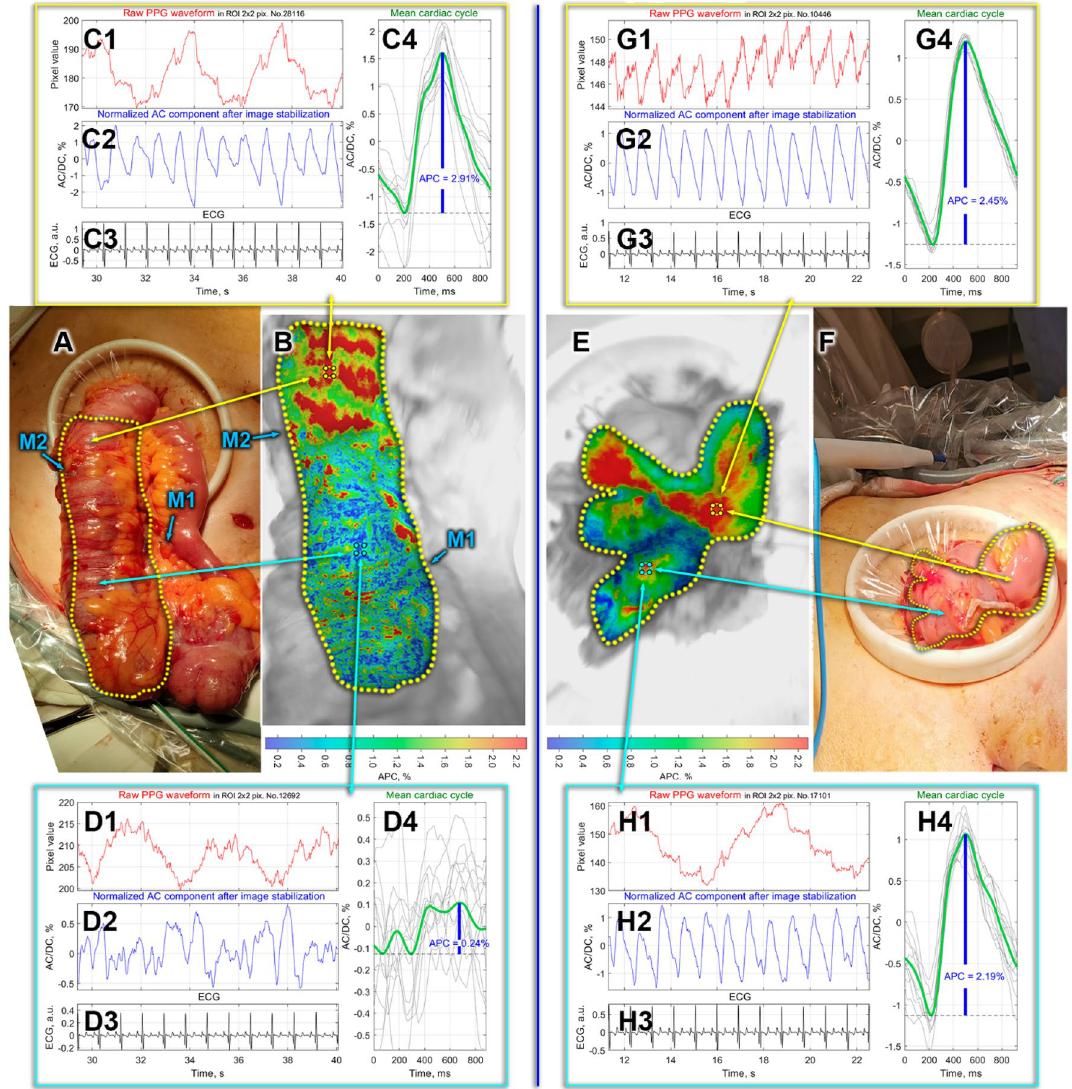
Figure 2. Intestinal blood perfusion in the case of side-to-side anastomosis. Panels ( A,F ) are color photographs of patient’s intestines before and after anastomosis, respectively. Spatial distributions of the APC before and after anastomosis overlaid on the respective intestine images are shown in Panels ( B,E ), respectively. Points M1 and M2 mark the boundaries of visible vascularization and mesenteric attachment, respectively. The color bars in the bottom of Panels ( B,E ) show APC percentagewise. Panels ( C,D ) and ( G,H ) demonstrate PPG pulses in selected ROIs before and after anastomosis, respectively. The meaning of the graphs in these panels is the same as in Fig. and right branches of the middle colic vessels with D3 lymphadenectomy. After mobilization of the right sections of the colon and terminal ileum, these sections together with the tumor were extracted through a minilaparoto- mic incision (5 cm) in the umbilical zone. Perfusion zones were formed because of ligation of regional vessels. Clips were placed on the ileum and transverse colon (M1 and M2 in Fig. 2A) marking the place of attachment of the mesentery with the main vessels and the border of visible vascularization, respectively. The area with signifi- cant decrease in perfusion was located at a distance of 3 cm from the visible edge of the mesentery. After the aforementioned surgical preparation, the perfusion of the colon prepared for anastomosis was measured by the iPPG system. The distribution of the APC parameter is shown in Fig. 2B. It is clearly seen that in the upper part (according to the orientation of the photo in Fig. 2B) of the colon (above the M2 mark), the APC is significantly higher than in the lower part: 2.46 ± 0.38% versus 0.73 ± 0.45%. Moreover, one can see in Fig. 2D that in the lower part of the colon, the PPG pulses are completely out of sync with the ECG. In contrast, in the upper part of the colon, there is a confident synchronization of PPG and ECG, forming a typical shape of the mean PPG pulse (see Fig. 2C). This result is in good agreement with the surgeon’s assessment of the blood supply. After the iPPG measurements, both intestines were transected at the level (mark M2) near the border of the dissected mesentery with the vessels using a three-row linear stapler DST. Side-to-side antiperistaltic